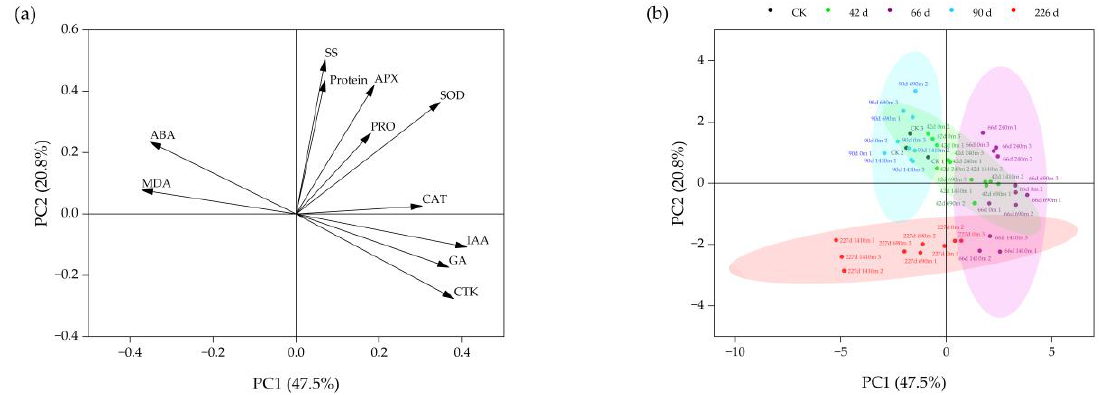
Figure 2. ( a ) Loading plot of principal components analysis (PCA) on biochemical indicators of deep underground stored canola seeds. Protein content, mgprot/ mL ; SS: Soluble sugar, mg/g ; SOD: superoxide dismutase, mg/g ; CAT: catalase, mg/g ; APX: ascorbate peroxidase, mg/g ; MDA: malondialdehyde, nmol/g ; PRO: proline, μg/g ; IAA: indoleacetic acid, ng/g ; GA: gibberellin, ng/g ; CTK: cytokinins, ng/g ; ABA: abscisic acid, ng/g . ( b ) Score plot of PCA. Each dot represents one replication, and the different colored areas are 95% confidence ellipse of different treatments stored for different durations. In the two plots, the positions of the dots and arrows indicate the composite principal component score for each treatment and indicator, respectively.